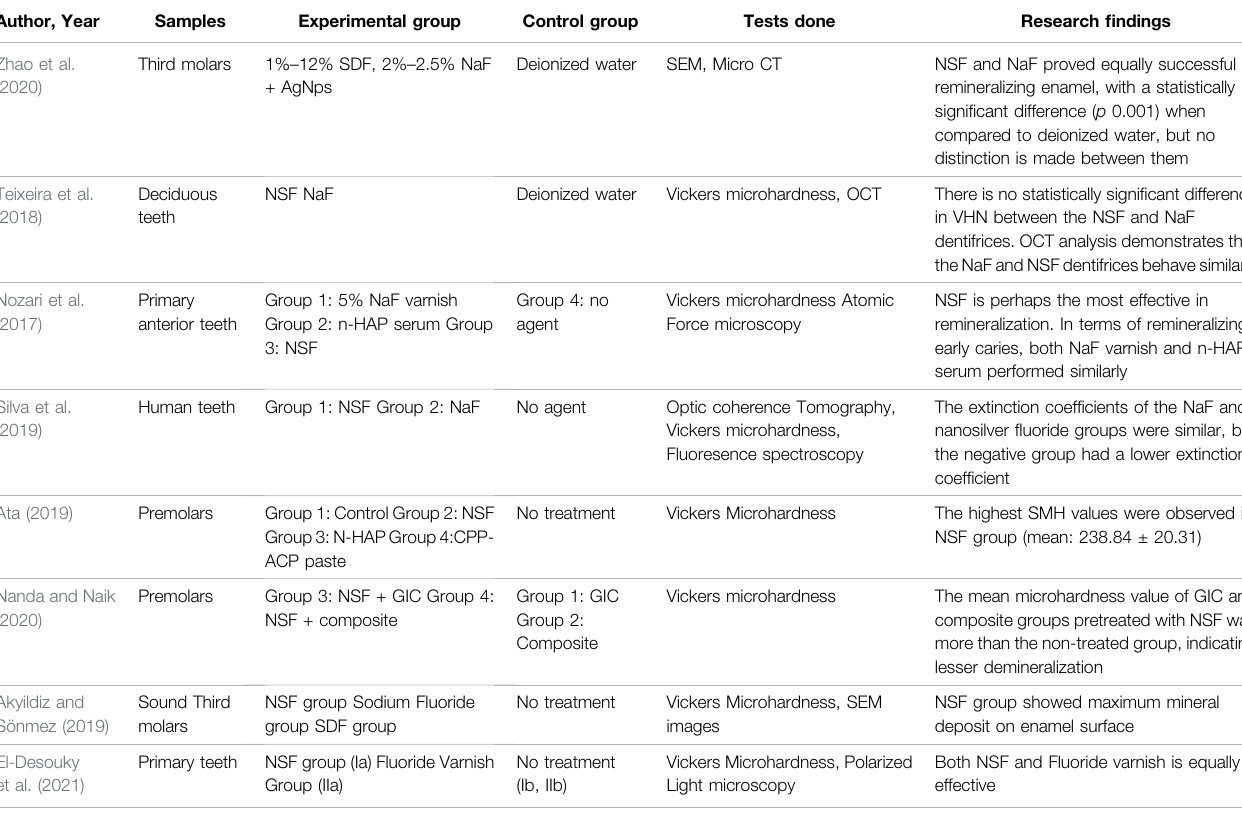
TABLE 2 | Studies related to remineralization potential of NSF for caries prevention.